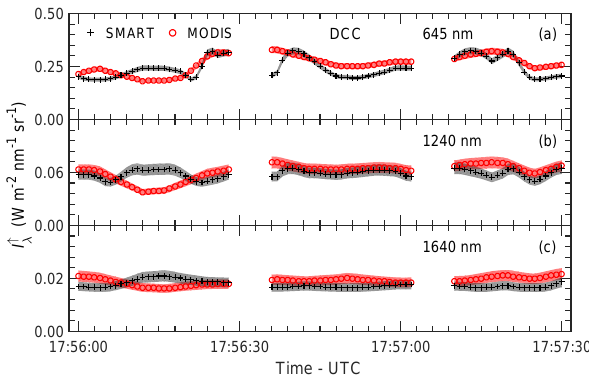
Figure 5. Same as Fig. 4 but for the DCC